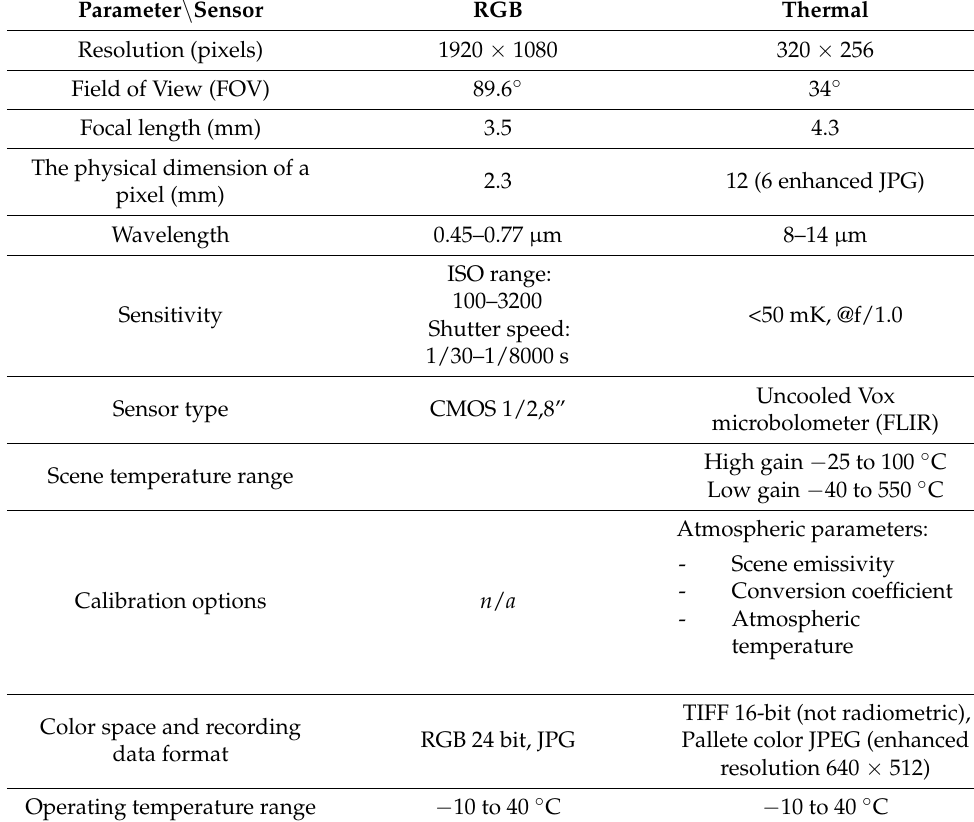
Table 1. Parameters of the E10T thermal camera (Yuneec H520)